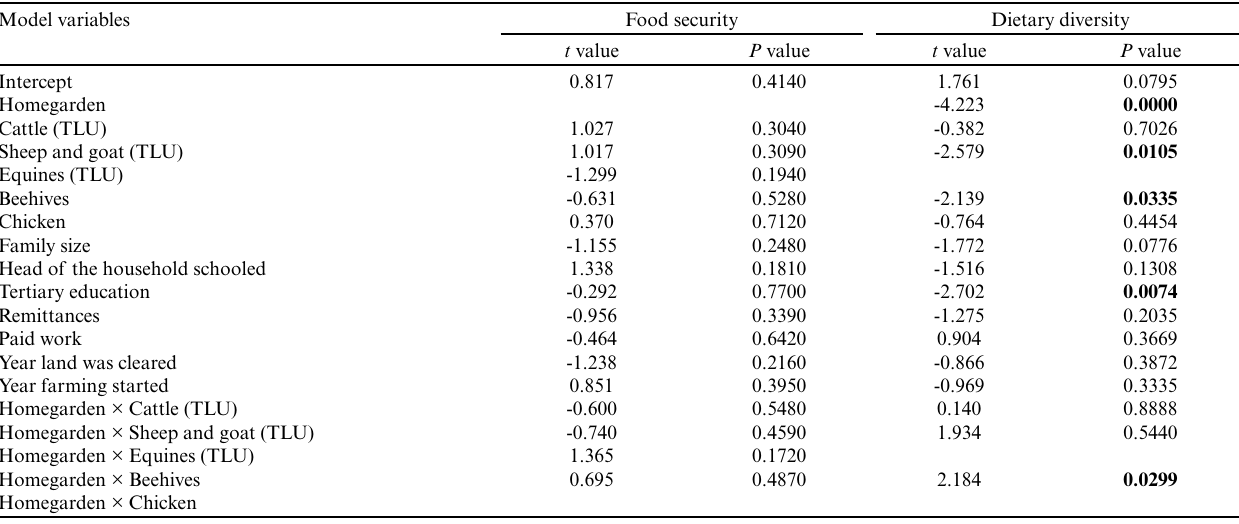
Table 4 . Summary of the results of Model 2 for explaining the variability in food security (months of adequate food provisioning) and dietary diversity (household dietary diversity score). Significant effects ( P < 0.05) are shown in bold (Homegarden: presence of absence of a homegarden; TLU: tropical livestock unit).